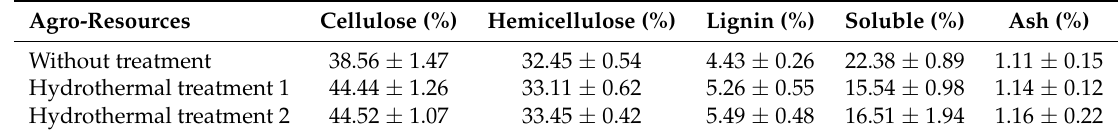
Table 3. Chemical composition of wheat straw without treatment and after hydrothermal treatments 1 and 2 (1: infusion at 80 °C, 2: infusion at 80 °C and heating at 180 °C).